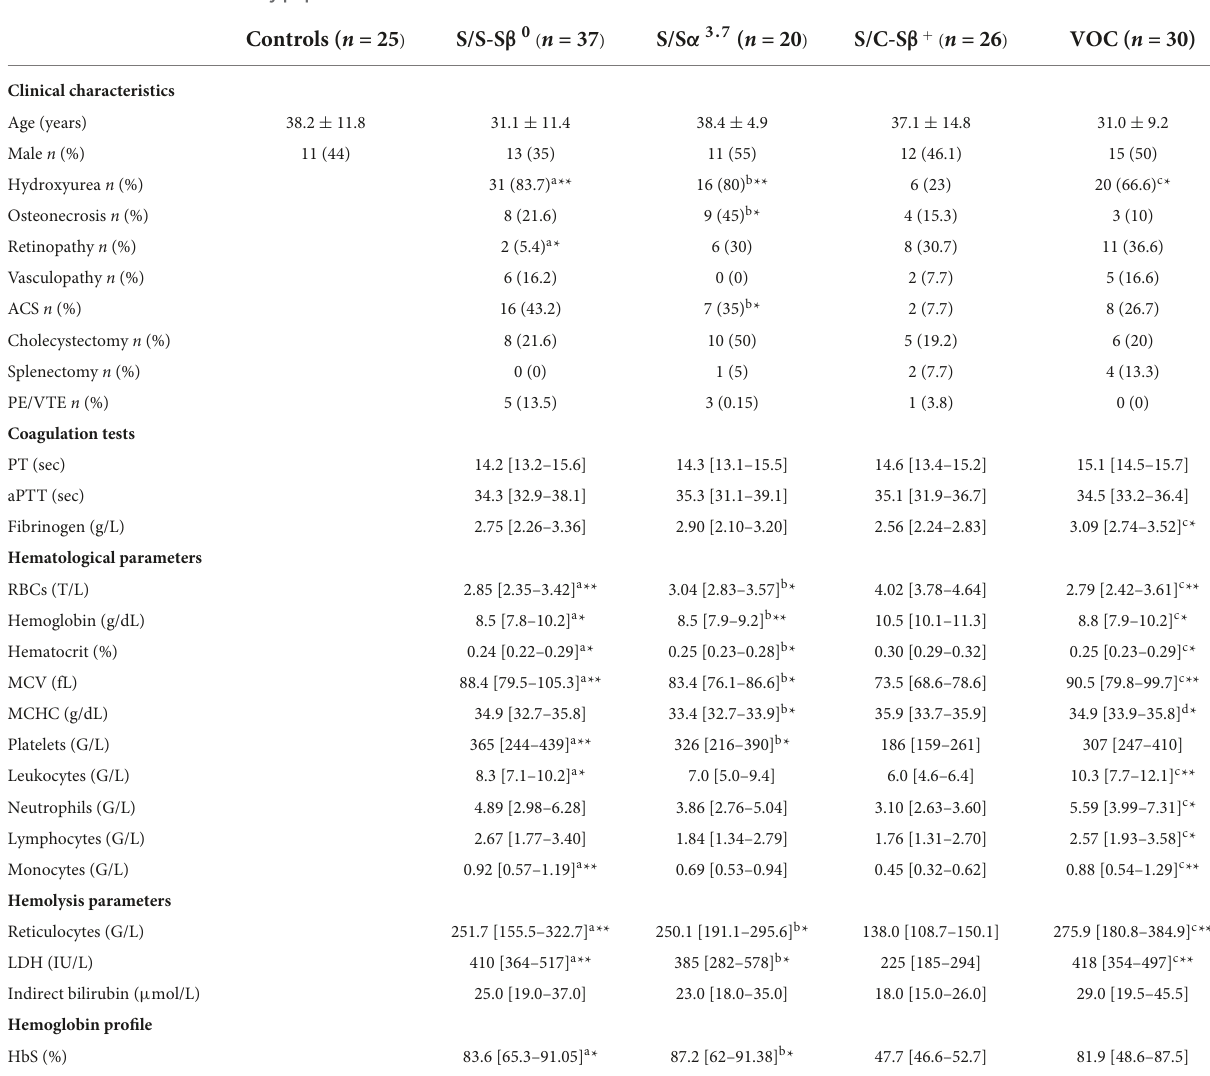
TABLE 1 Characteristics of study